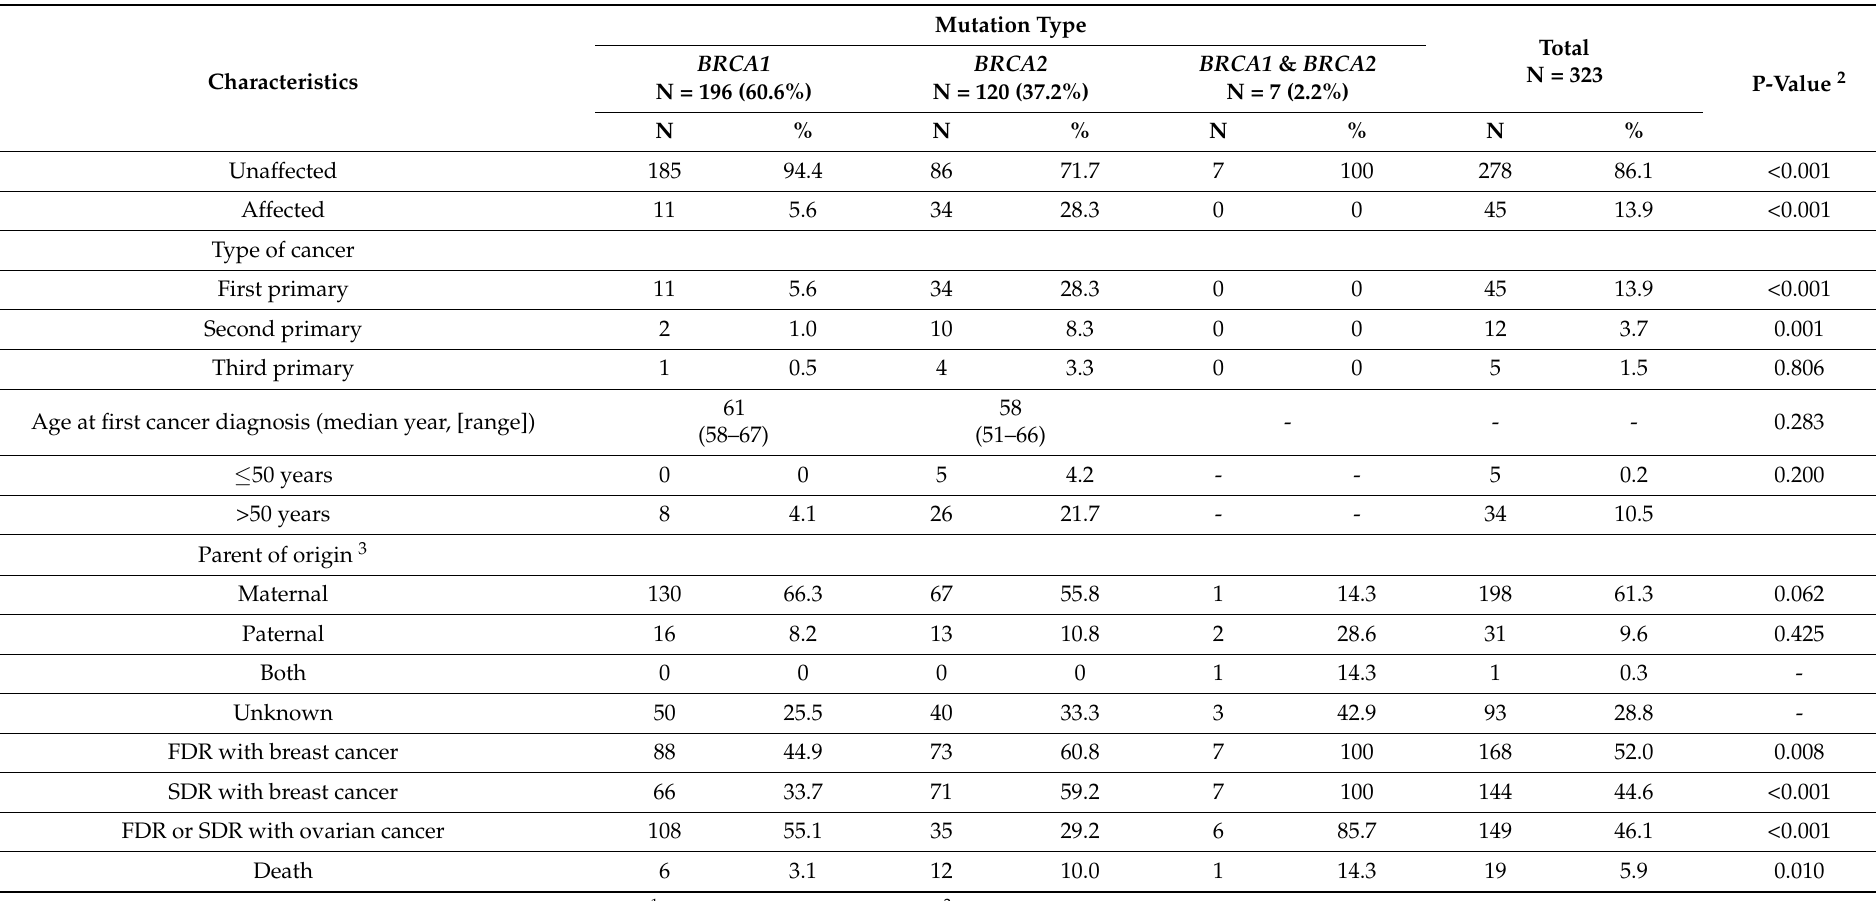
Table 1. Baseline characteristics of men with BRCA1/2-mutations 1